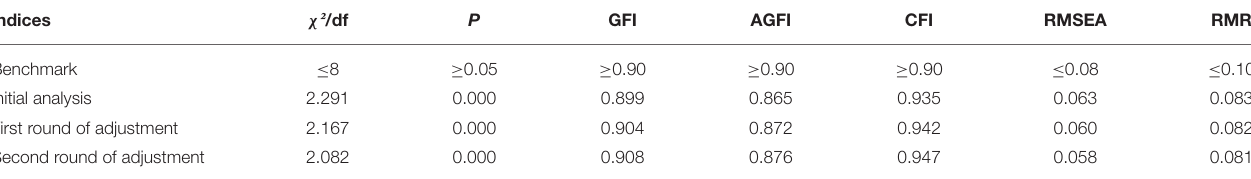
TABLE 3 | CFA results of the initial analysis and two rounds of model